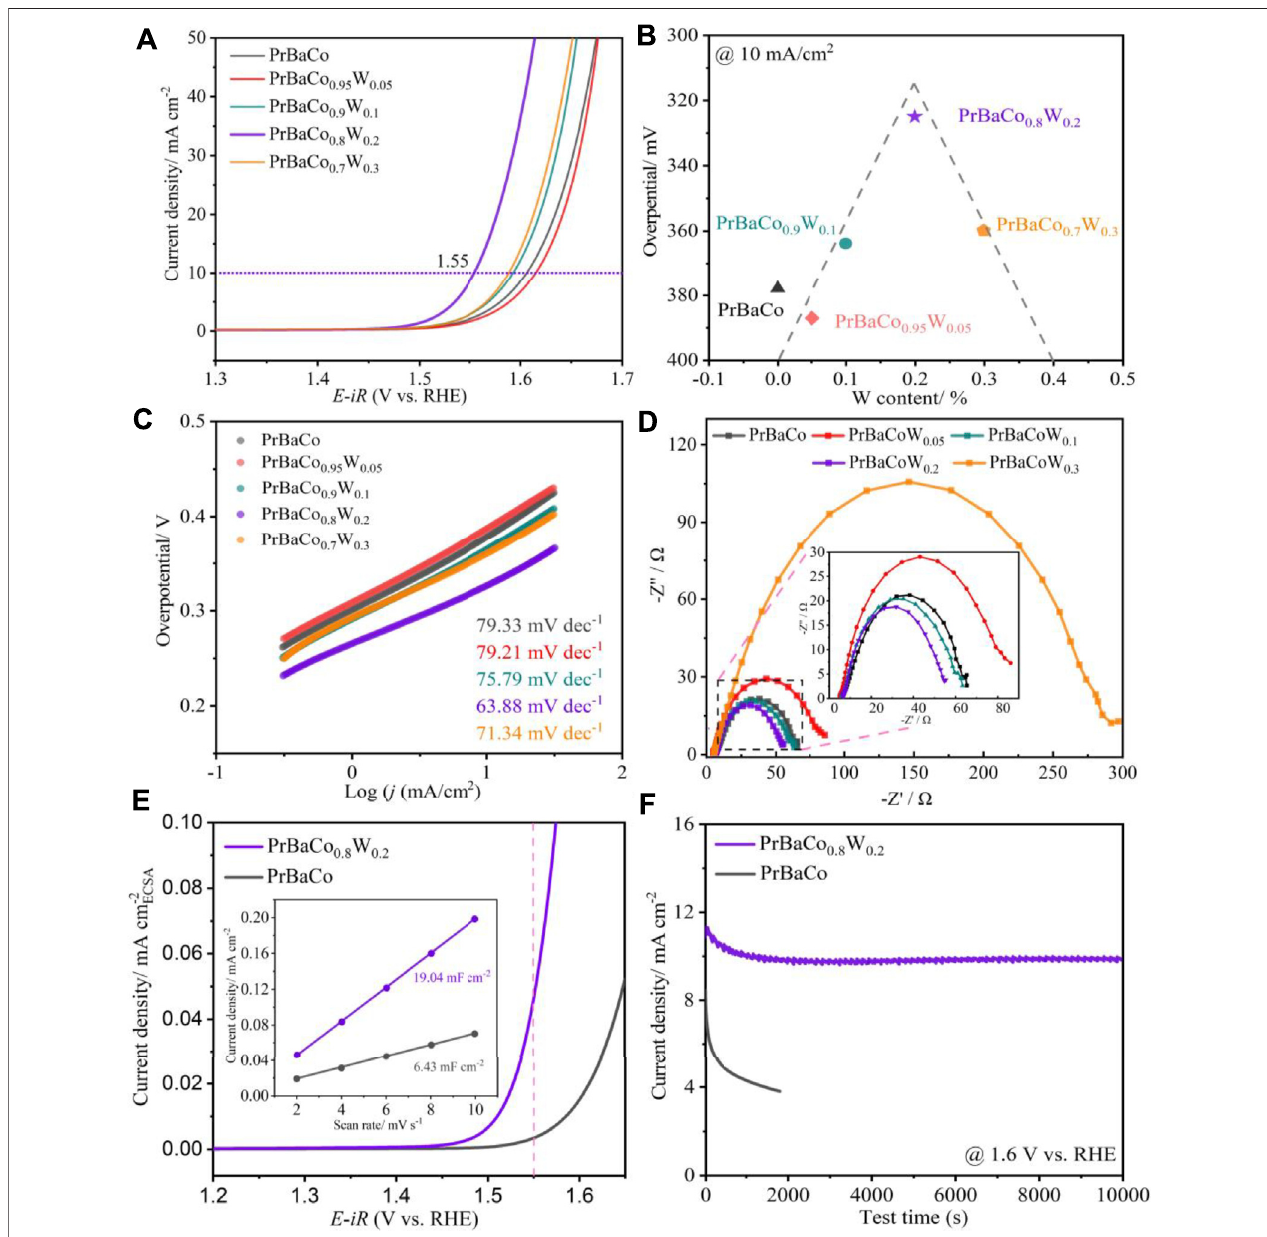
FIGURE 4 | (A) Linear sweep voltammetry (LSV) polarization curve of various catalysts. (B) The volcano curves. (C) Corresponding Tafel slopes. (D) EIS plots. (E)